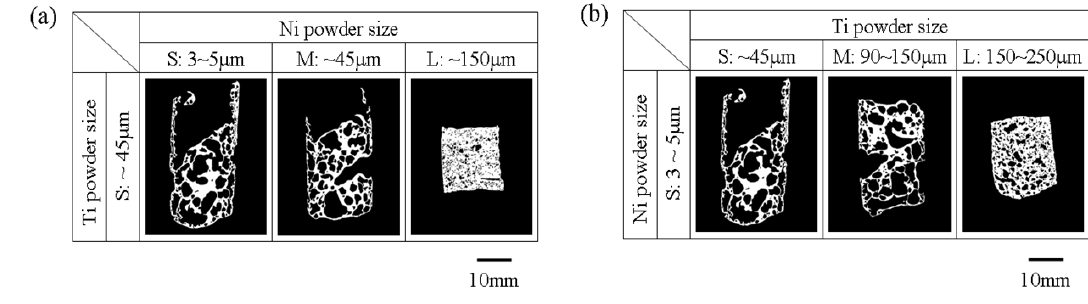
Figure 3. Combustion synthesized foams made using coarse TiB different ( a ) Ni; and ( b ) Ti particle sizes.